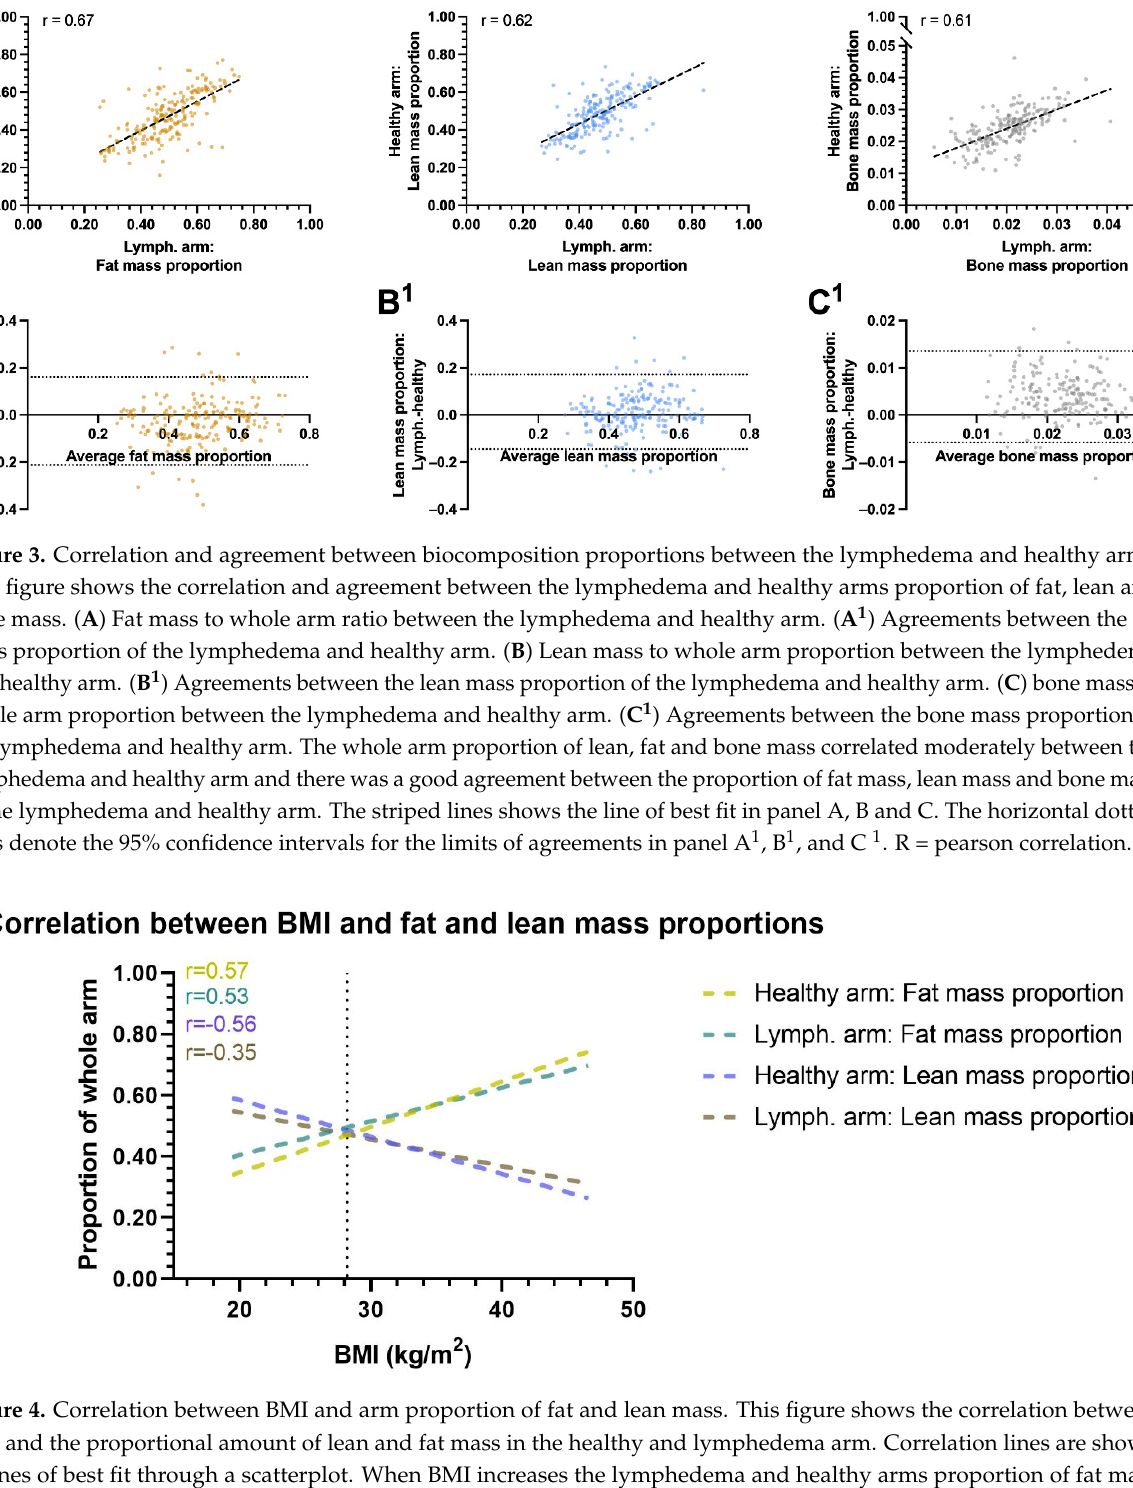
<0.001 Table 2 legend: This table shows the multivariate linear regression models for lymphedema volume, fat mass, and lean mass predictors. n.s = not significant. 3.2. Fat and Lean Arm Mass Proportions In the univariate analysis, the lean mass proportion of the lymphedema arm was as- sociated with the lean mass proportion of the healthy arm (r = 0.62, p < 0.001, Figure 3A)